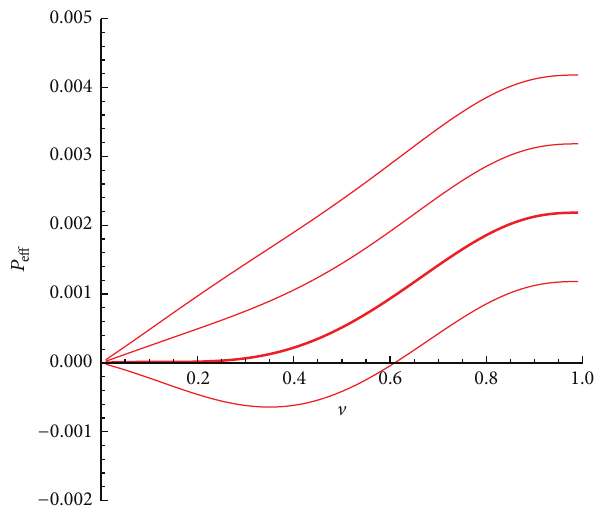
− V diagram of RN-dS black holes. The temperature Figure 1: 𝑃 eff of isotherms decreases from top to bottom and corresponds to 𝑇 𝑐 + 0.004 , 𝑇 𝑐 + 0.002 , 𝑇 𝑐 , 𝑇 𝑐 − 0.002 .